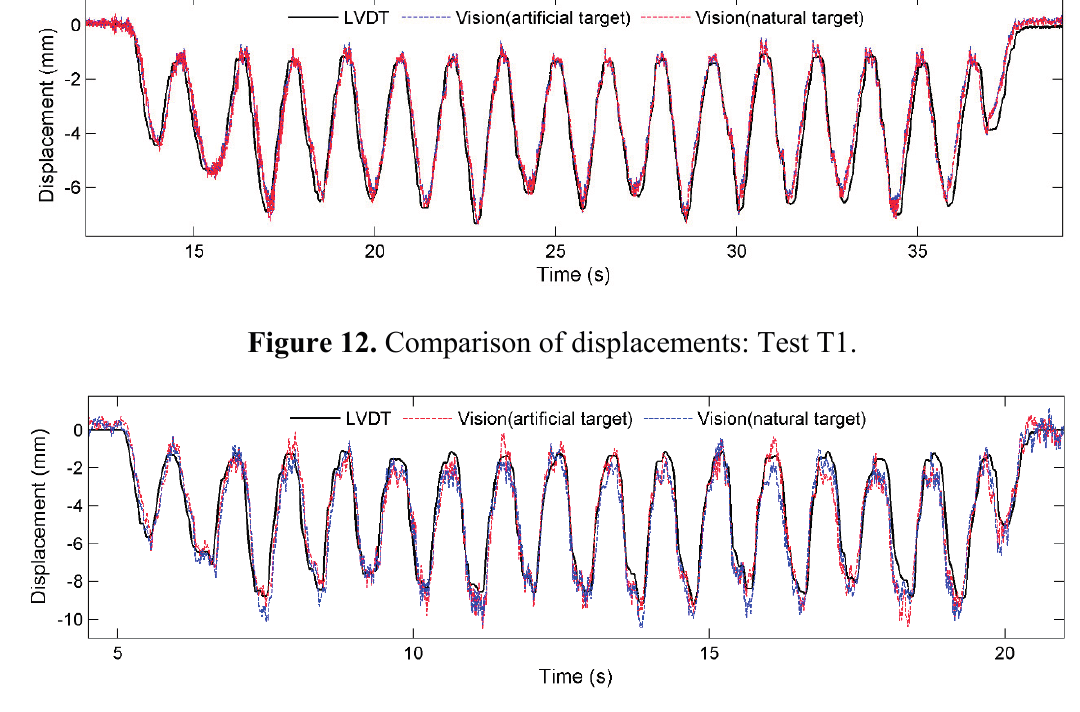
Figure 13. Comparison of displacements: Test